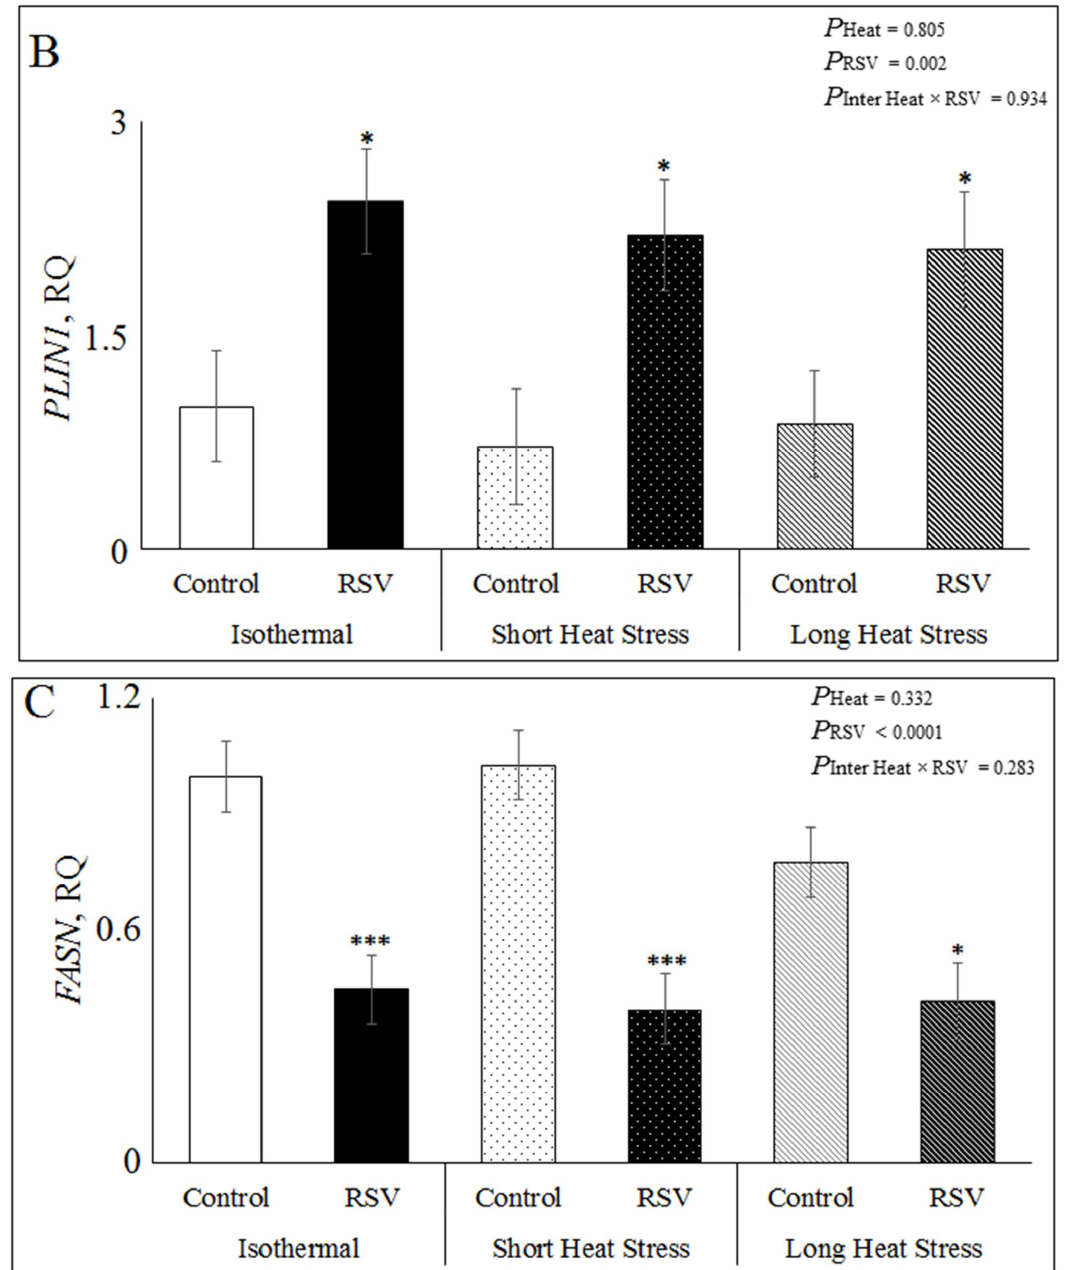
Figure 4. Effect of resveratrol (RSV; at 100 µ M for 48 h) under isothermal (ISO; 37 ◦ C for 48 h), short heat stress (SH; 37 ◦ C for 47 h and 41.2 ◦ C for last 1 h), or long heat stress (LH; 37 ◦ C for 32 h followed by last 16 h at 41.2 ◦ C) on relative expression of lipid metabolism in DFAT cells. ( A ) Relative gene expression of hormone sensitive lipase ( LIPE ); ( B ) Relative gene expression of perilipin 1 ( PLIN1 ). ( C ) Relative gene expression of fatty acid synthase ( FASN ). P heat is the significance of heat stress treatments, P RSV is significance for RSV treatment and P inter Heat × RSV is significance of interaction of Heat × RSV. Within each heat treatment, * indicates p < 0.05, *** indicates p < 0.001 and # indicates p = 0.06 between control and RSV treatments.